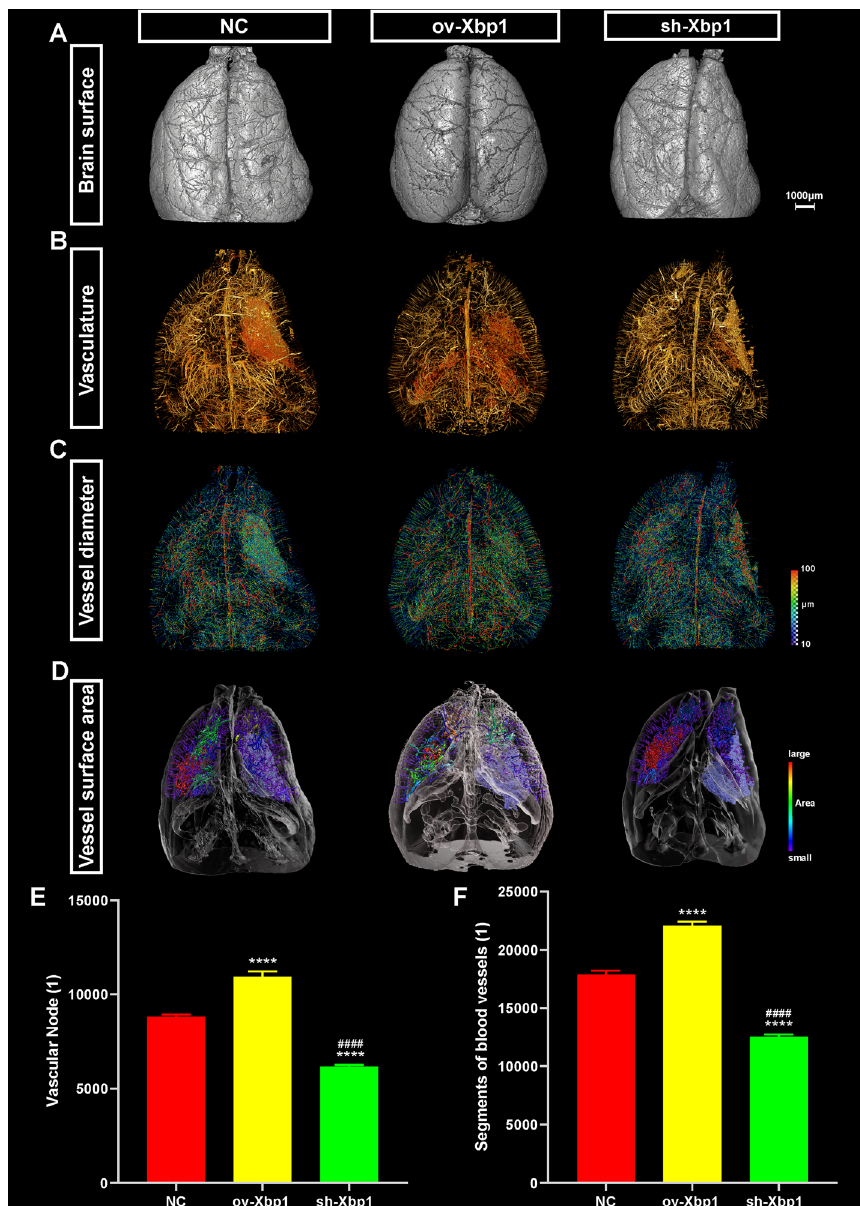
Fig. 6 (See legend on previous